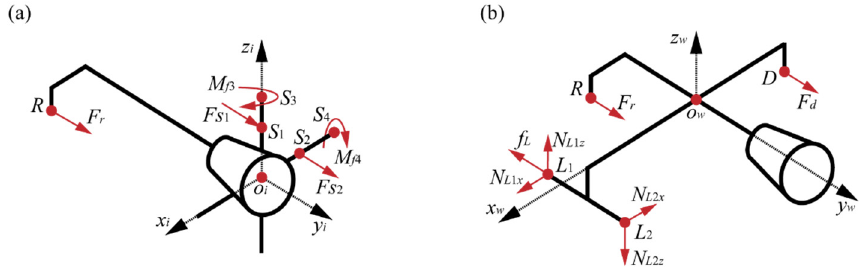
Figure 10. Free-body diagram of ( a ) the preloading condition of spring pins and ( b ) free stretching. Then, the drogue stretches at a constant, continuous speed until it contacts the probe.